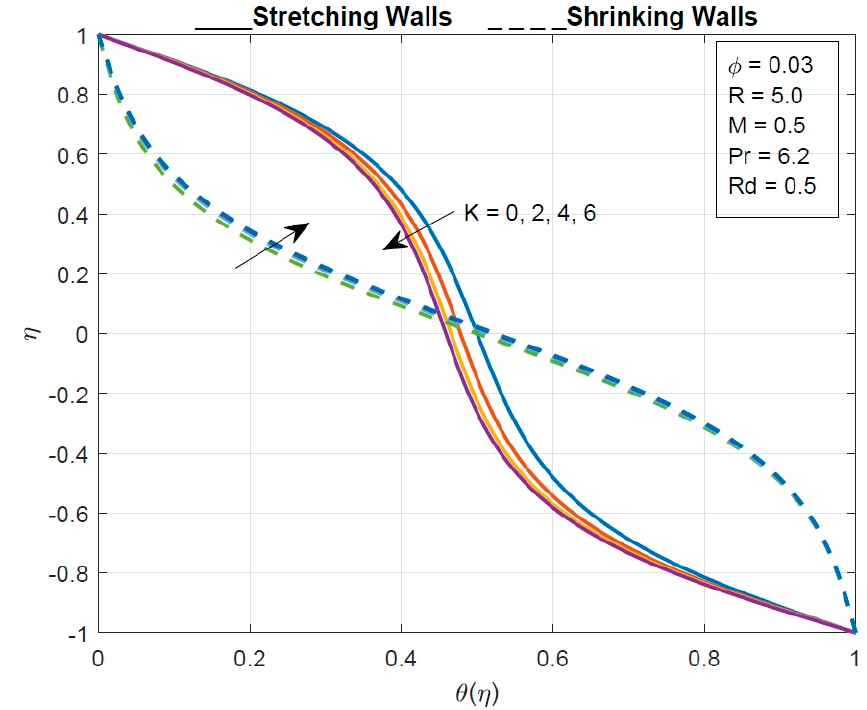
Figure 5. The effect of the micropolar parameter on the temperature profile.